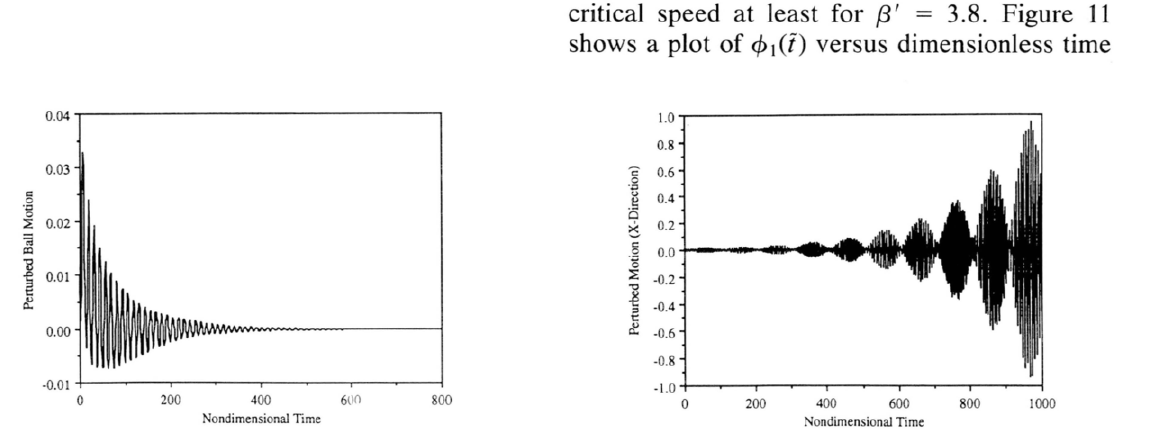
FIGURE 12 X-direction perturbation versus nondi mensional time (w = 1.0). Initial conditions: xo(O) = .90(0) = 0.01, i o(O) = Yo(O) = 0, ¢ sl = 3.13, ¢s2 = 3.15, ¢I(O) = ¢ 2(0) = 0.01 , ¢I(O) = ¢ z(0) = 0, m = 0.005, R = 0.001 , and {3' =